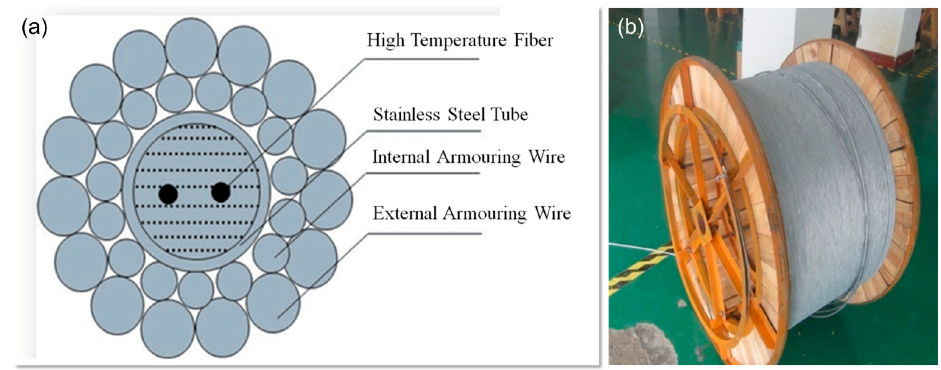
Figure 20. ( a ) Cross-section structure of downhole cable; ( b ) Photo of the 10 km-long downhole cable.